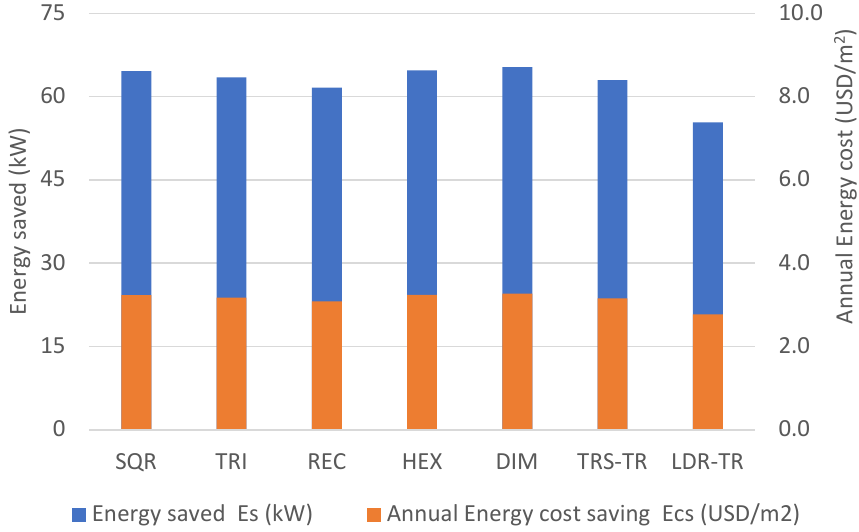
Figure 8. Energy saved and associated electricity cost ($0.05/kWh) using different 3DPC infill structures versus a concrete brick wall.